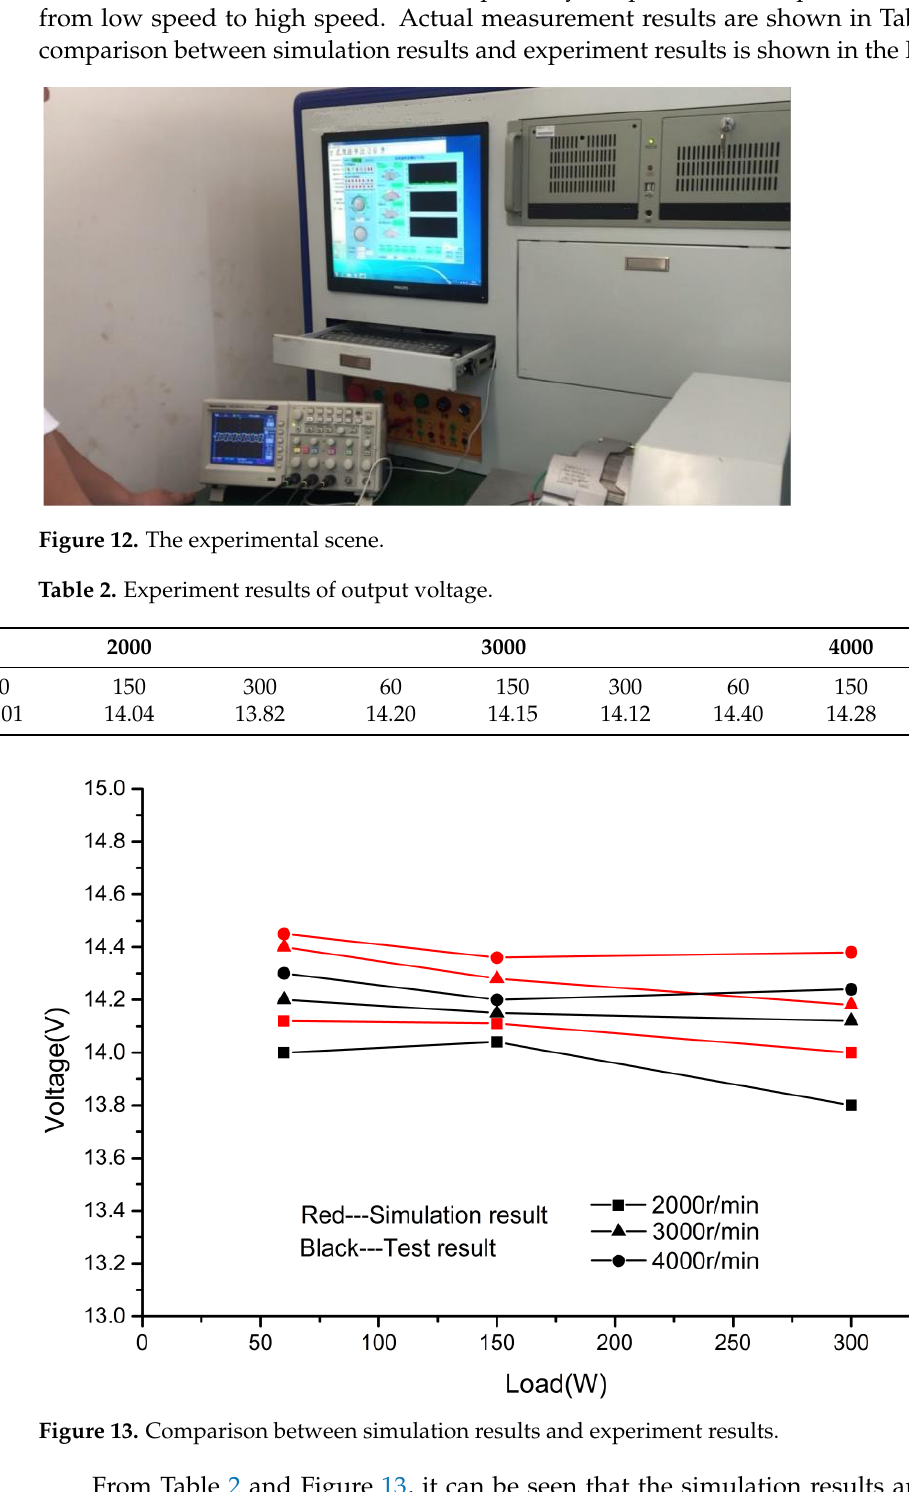
(15) Table 1. Simulation calculation results of the output voltage. Speed (r/min)